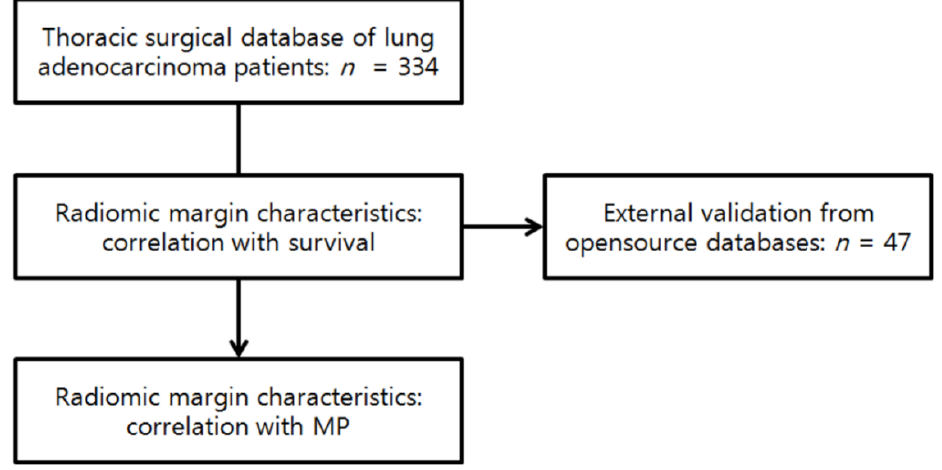
Figure 1. Flow chart of patients, including external validation.